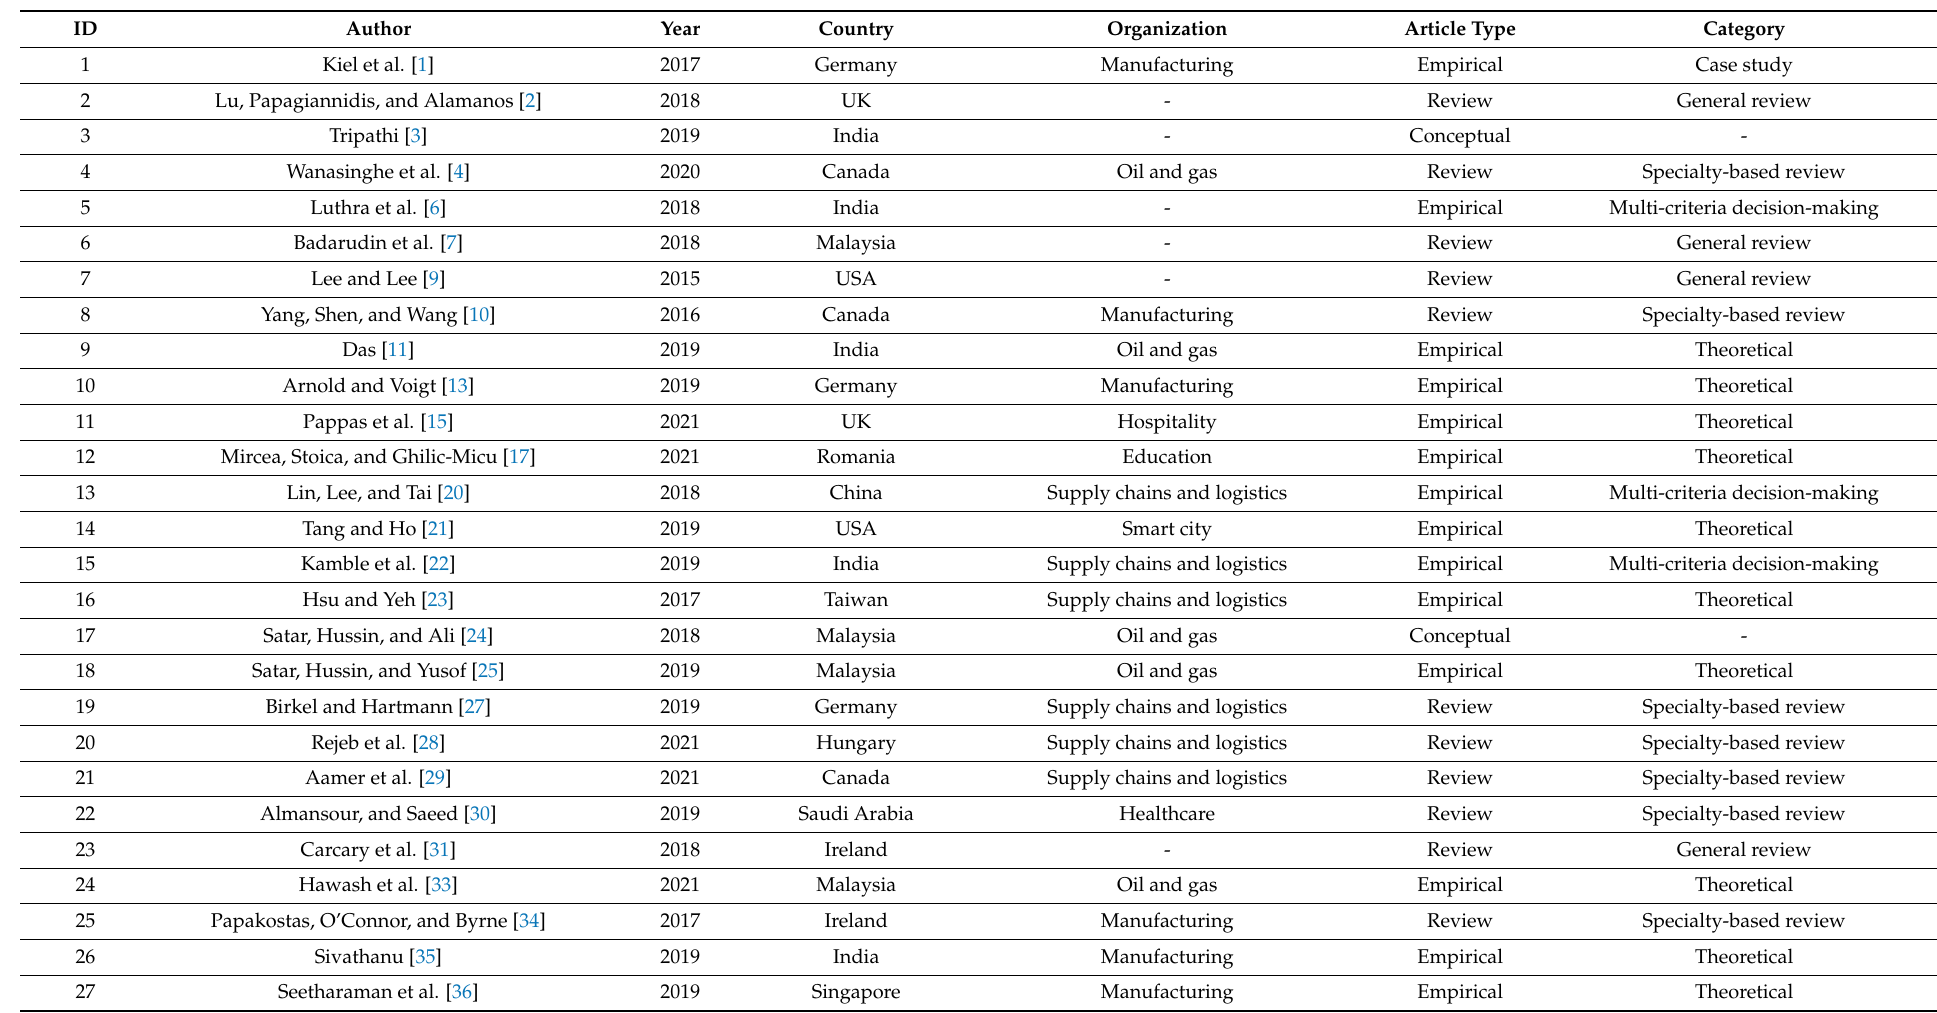
Table A1. Summary of the included